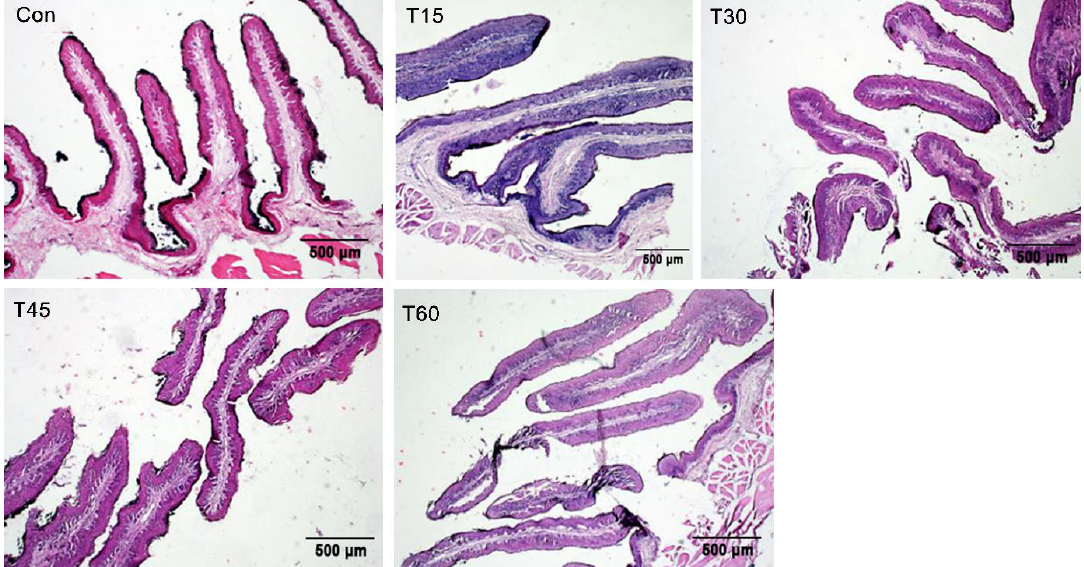
Figure 3. Morphological structure of rumen papillae in fattening Hu sheep fed with mulberry leaf powder (4 ×).